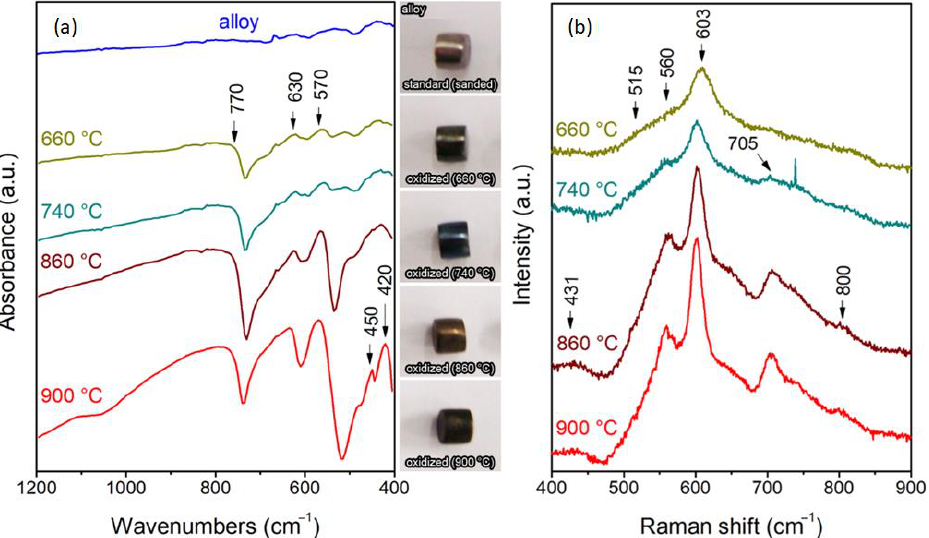
Figure 10. Ni-based alloy characterizations before and after the oxidation analyses at 660, 740, 860, and 900 °C: ( a ) FTIR and ( b ) FT-Raman.